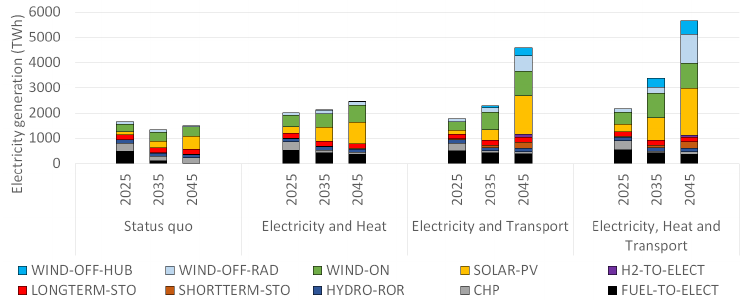
Figure 11. Electricity generation per scenario, year, and aggregated technology type in all the studied countries (TWh). Long-term electricity storage (LONGTERM-STO) includes large-scale hydro reservoirs without pumping. Short-term electricity storage (SHORTTERM-STO) includes hydro pumping and electric batteries (including electric